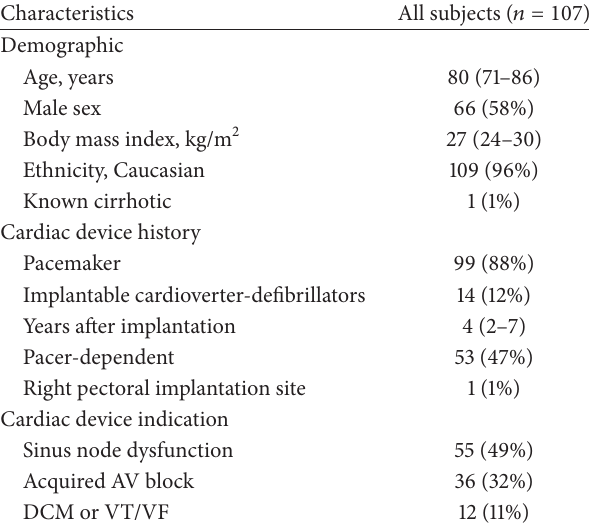
Table 1: Baseline characteristics.